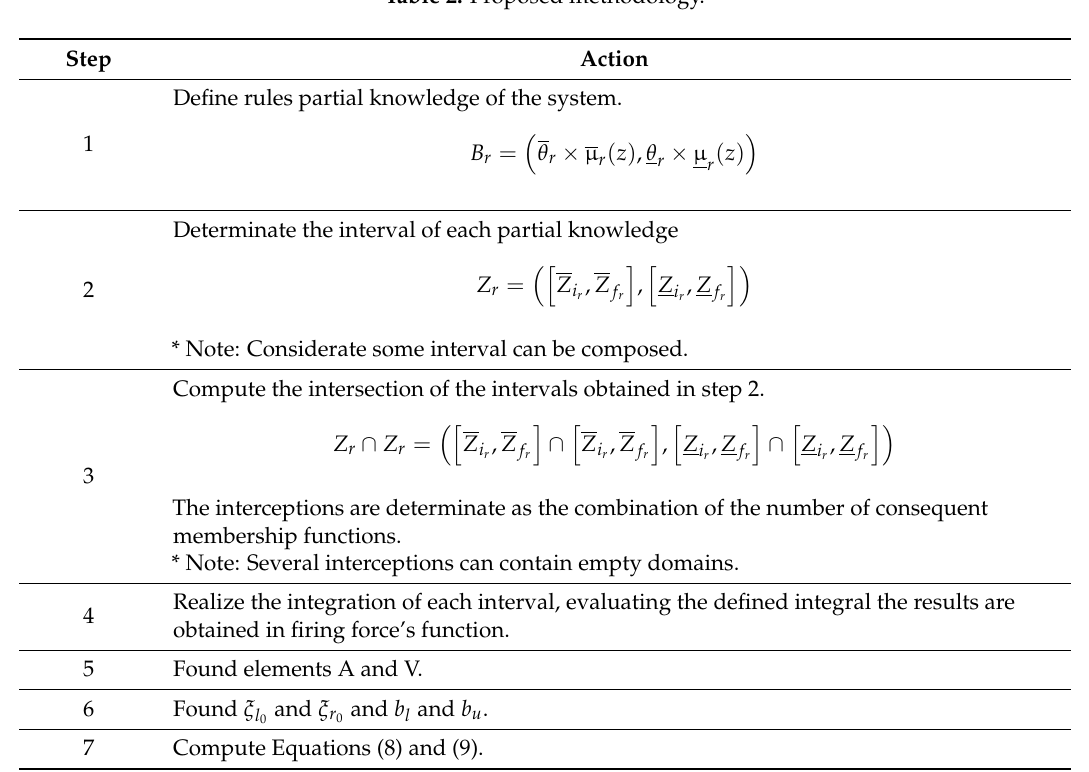
Table 2. Proposed